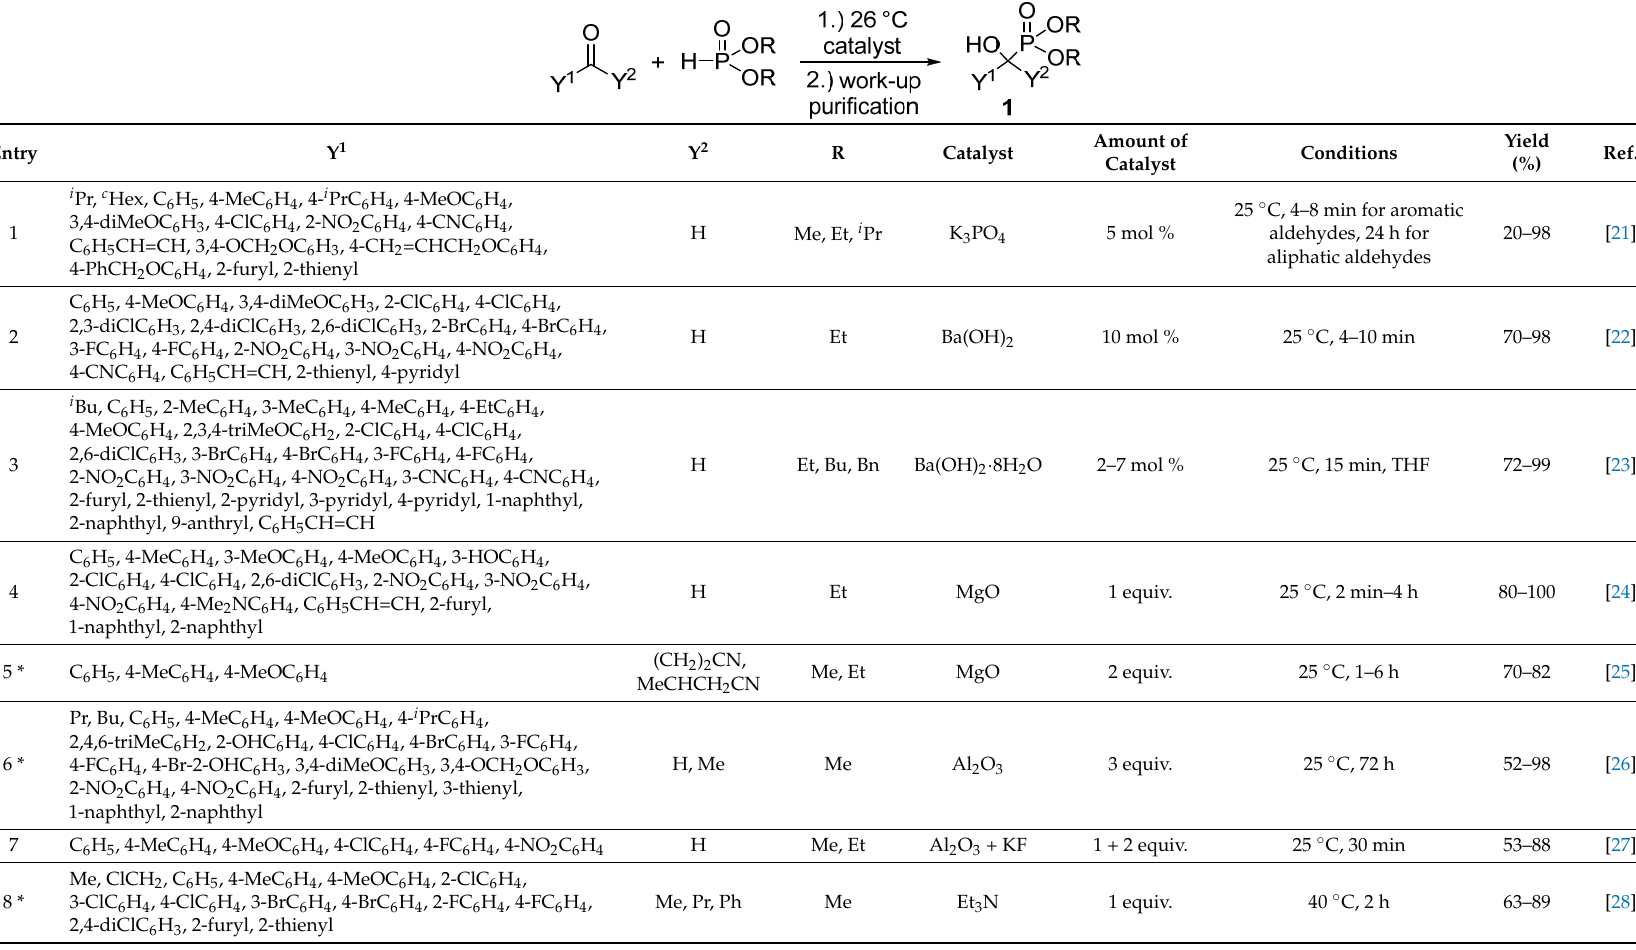
Table 1. Selected examples for the synthesis of α -hydroxyphosphonates ( 1 ) from aldehydes or ketones and dialkyl phosphites (method “A”).